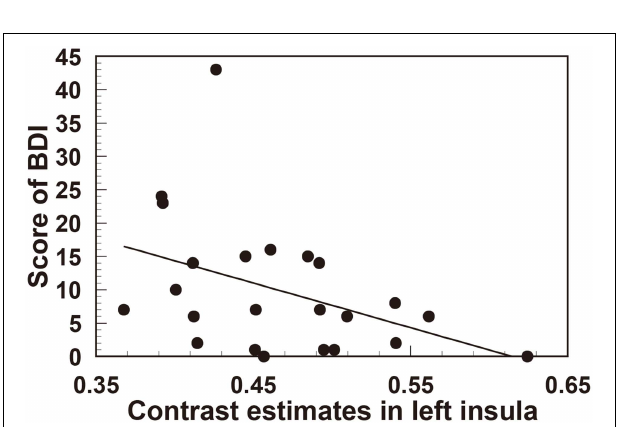
FIGURE 3 | Significant negative correlation between regional gray matter volume in the left insula and the scores of the STAI (trait anxiety) questionnaire.